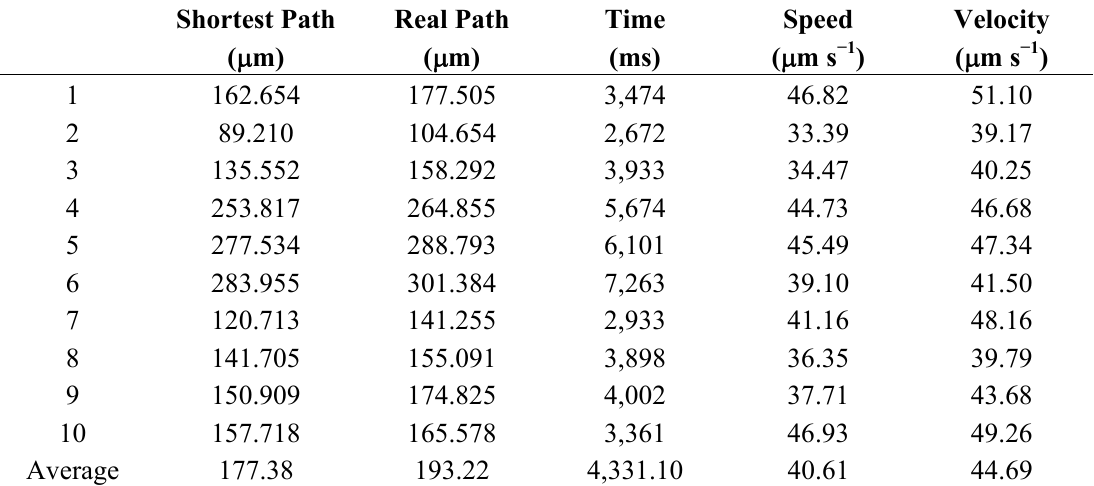
Table 4. Experiment data with voltage as control